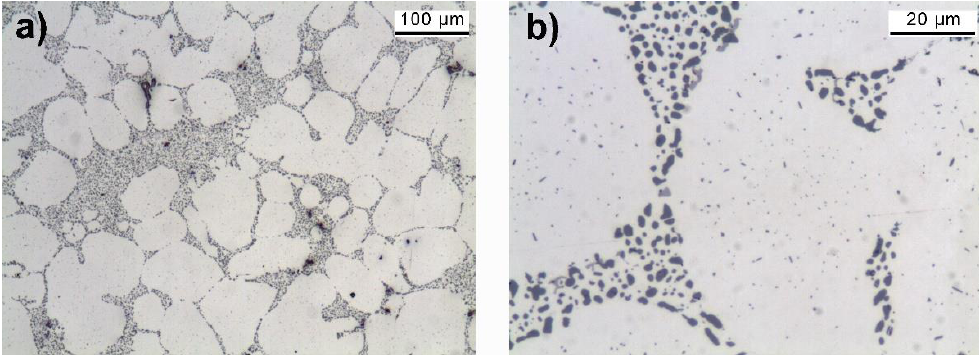
Figure 8. Micrographs at ( a ) low and ( b ) higher magnifications of AlSi9Cu3(Fe) alloy solutioned at 470 °C for 6 h.